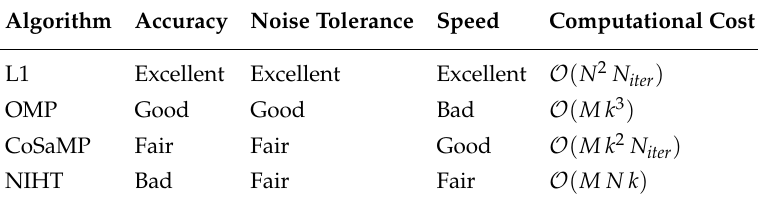
Table 2. Comparison, in terms of accuracy and speed, of the four algorithms L1, OMP, CoSaMP,